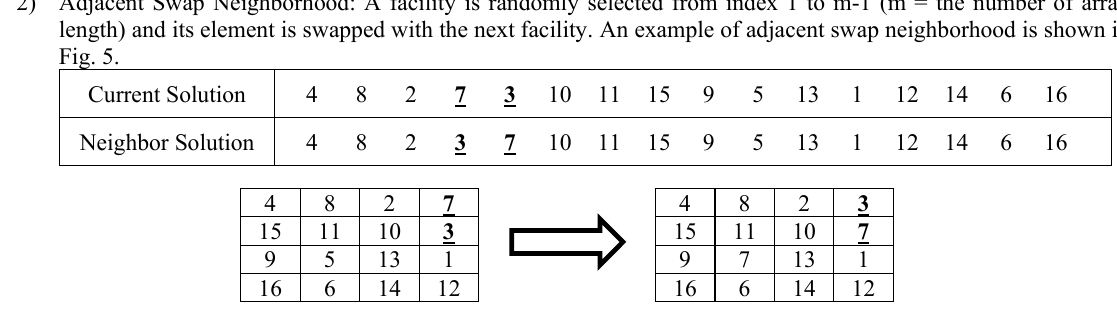
Fig. 4. An example of random swap neighborhood generation